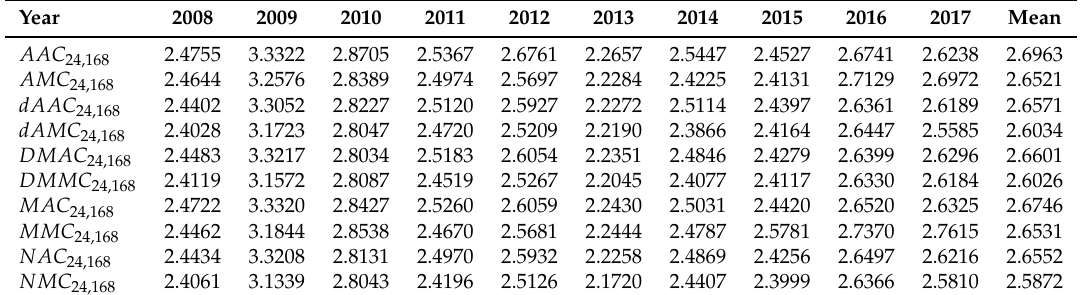
Table 2. Summary of the 24-hour ahead forecasting MAPE of double seasonal models, split by years.